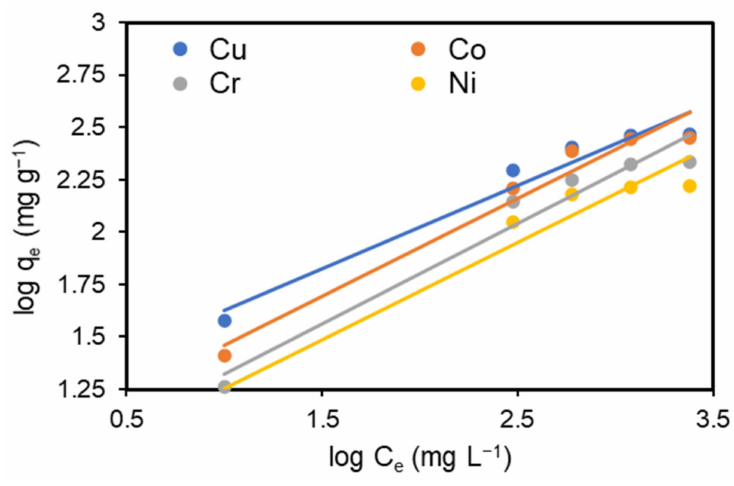
Figure 8. Linear plots of Freundlich adsorption isotherm of metal ions by poly(amidoxime) ligand. Table 4. Linear Freundlich adsorption isotherm parameters of poly(amidoxime) ligand. Adsorbent